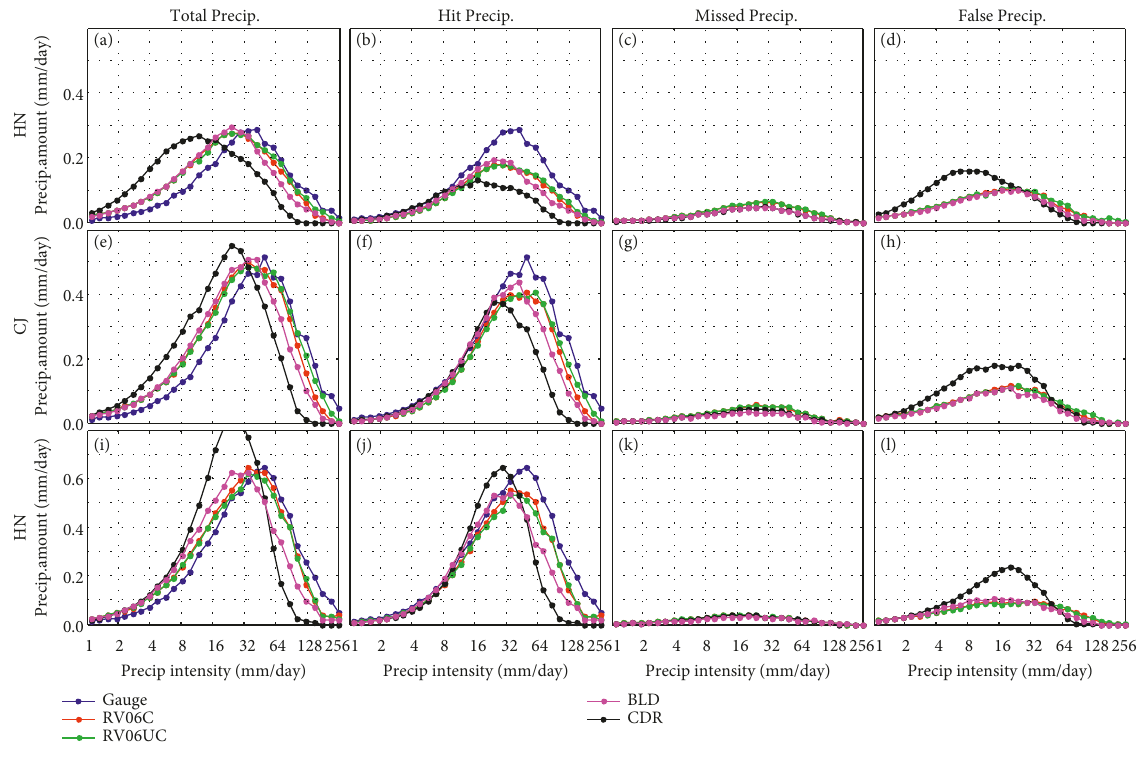
Figure 14: Same as Figure 12 except for the HB, CJ, and HN